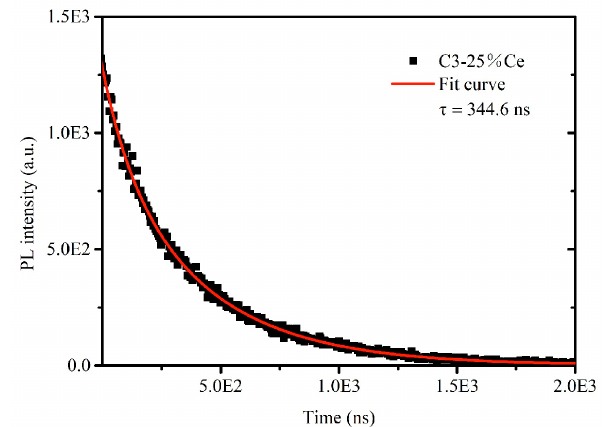
Figure 8. The PL decay curve of the sample C3 and its fit curve.